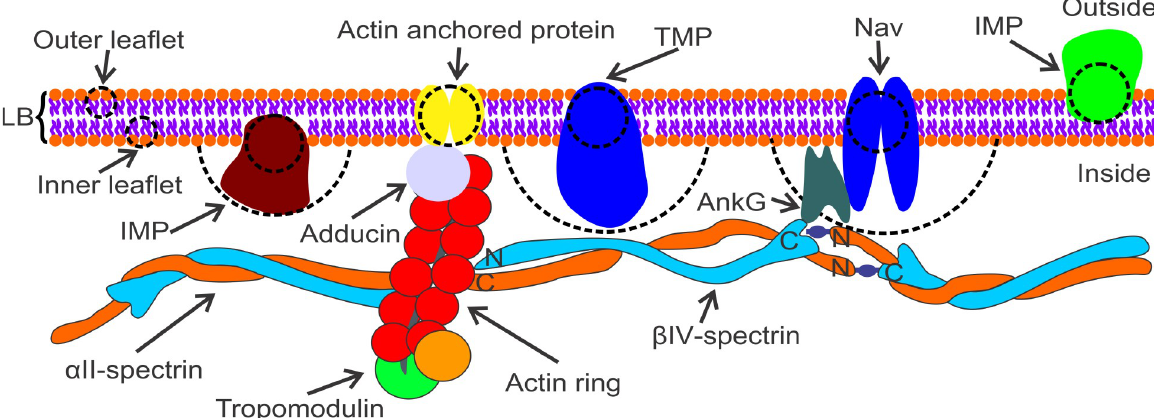
Fig 2. Illustration of the APM, which includes the APMS and the phospholipid bilayer. Ankyrin G binds to the 15 th repeat of β -spectrin near its carboxyl terminus and to Na v in the axon. α -spectrin and β -spectrin filaments are connected at actin junctions. It is unknown how the phospholipid bilayer is anchored at the actin rings; we indicate a generic actin-associated protein that connects the actin rings to the phospholipid bilayer. Cluster of lipids in the individual layer are represented by a particle with a diameter of 2.5 nm, which is approximately the thickness of a single phospholipid bilayer. We chose the size of TMPs and IMPs of both the inner and outer leaflets to be 5 nm when they interact with other membrane proteins and lipids. However, the IMPs of the inner leaflet and TMPs have additional components that extend towards the cytosol, whereas the IMPs of the outer leaflet do not have inner extension regions. The effective size of the IMPs of the inner leaflet and the TMPs is considered to be 20 nm and 25 nm, respectively, when they interact with the APMS.